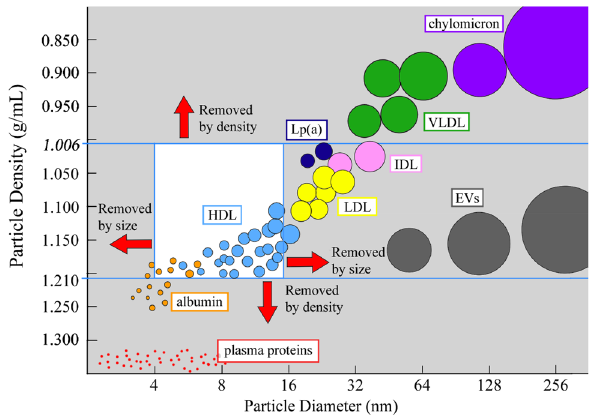
Figure 1. Schematic of the size and density range of lipoproteins and low-density plasma components. The white box indicates the density and size of high density lipoprotein (HDL) particles captured by this HDL isolation method, as well as the particle diameter (nm) and particle density (g/mL) of the other lipoprotein particles—chylomicrons, very low density lipoproteins (VLDL), intermediate density lipoproteins (IDL), low density lipoproteins (LDL), lipoprotein (a) (Lp(a)), and extracellular vesicles (EVs) present in plasma that are simultaneously isolated as part of this